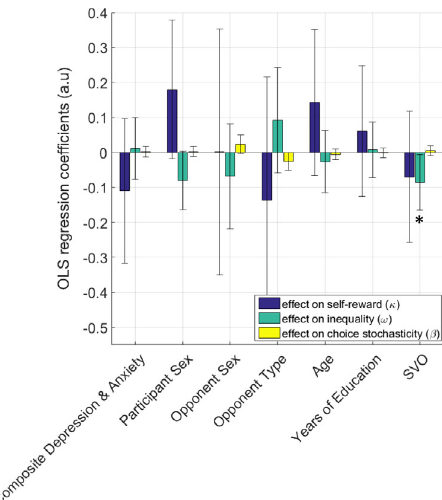
Fig. 5 Prosocial individuals perceive self – other inequality more negatively in the UG. Coef fi cient estimates from an OLS regression model fi tted to parameter estimates of the best- fi tting computational choice model (i.e. Model 10) suggested that people with higher social value orientation will perceive self – other inequality more negatively (* p < 0.05). A generate-recover simulation analysis (50 iterations) based on stochastic choices generated by this model demonstrates the stability of the estimated parameters (Supplementary Fig. 5). Error bars denote 95%